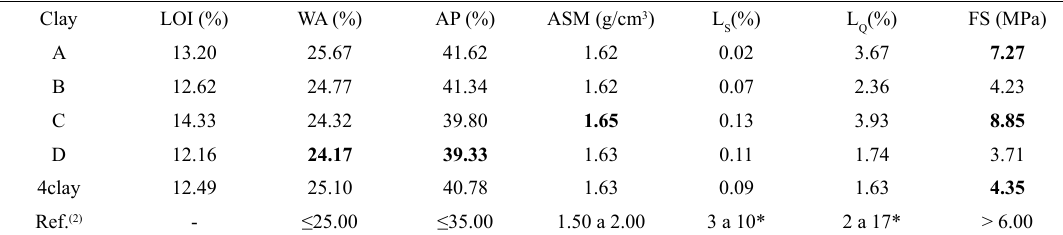
Table 4. Average values of the ceramic properties on the